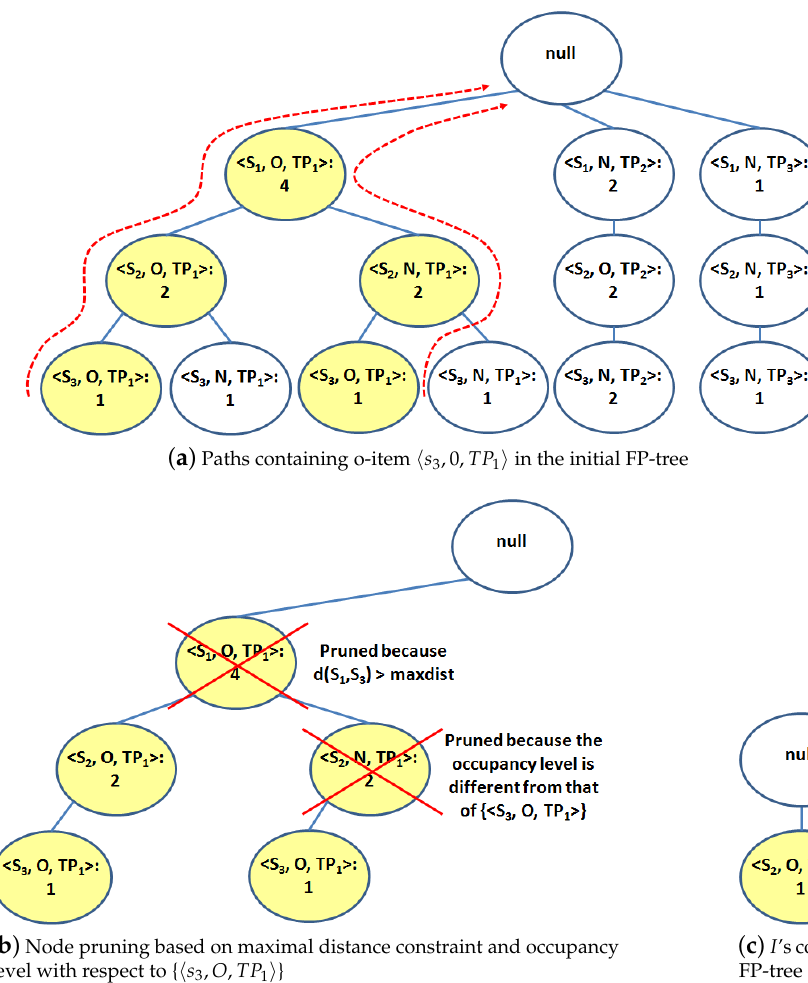
Figure 3. O-itemset mining